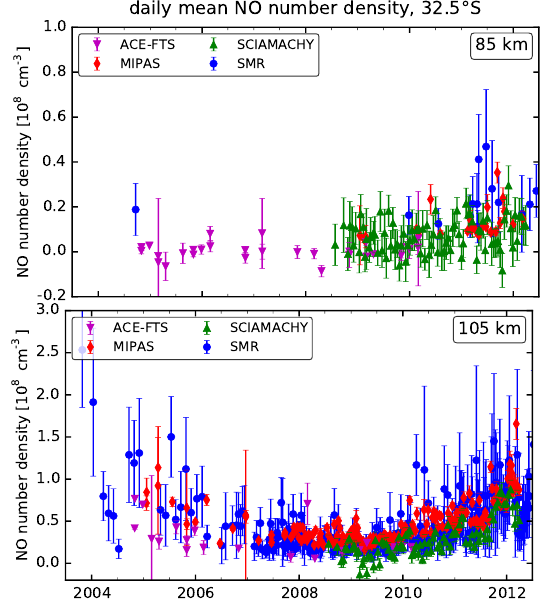
Figure 5. NO vertical profile comparison of the SCIAMACHY NO number density ( n SCIAMACHY ) to the other instruments ( n other ). NO NO − Shown is the median of the relative differences (n SCIAMACHY NO n other )/n other averaged over days coincident with other observa- NO NO tions. The panels show the results in the southern polar region (left), at middle and low latitudes (middle), and in the northern polar re- gion (right). The error bars indicate the 95% confidence interval using the median absolute deviation (3 × MAD). The numbers in parentheses denote the number of coincident profiles in these three regions from south (left) to north